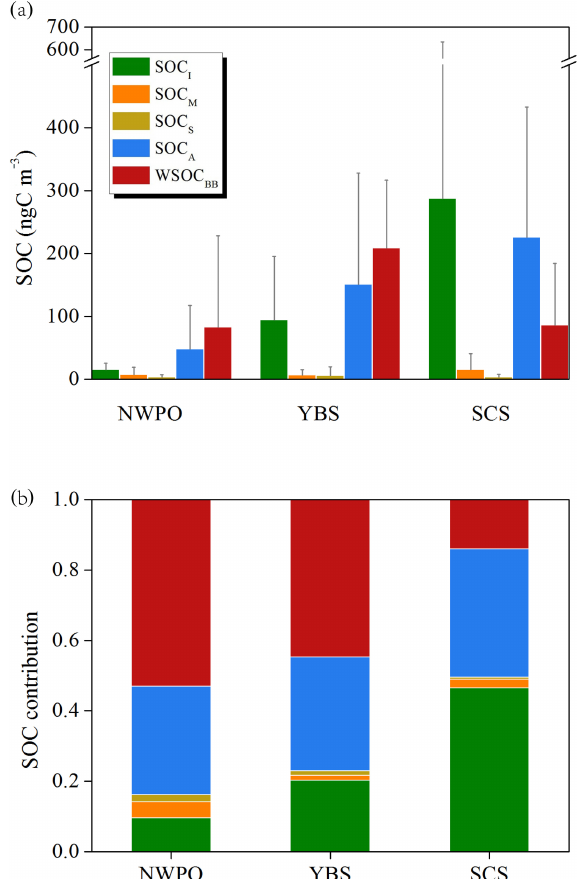
Figure 5. Average SOC levels calculated using the tracer- SOC/WSOC BB method over three marine regions (YBS and NWPO in 2014 and SCS in 2017) and their contributions based on five organic tracers measured in this